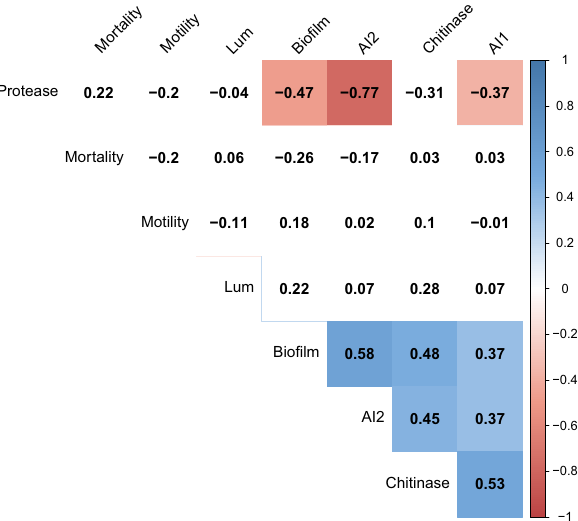
Figure 7. Correlation matrix (Pearson correlation coefficients) among virulence factors and pathogenicity. The highlighted block indicates a significant relationship (p < 0.05). Blue shade represents a significant positive correlation, while red indicates a significant negative correlation.